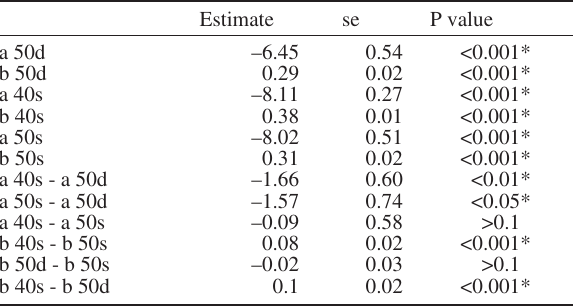
Table 3. – Logistic parameters (a and b) estimated by the mixed- effects model for the three mesh configurations (50d, 50-mm dia- mond; 40s, 40-mm square; 50s, 50-mm square), standard errors (se) and pairwise comparison between mesh configurations. The asterisk indicates significant P values, i.e. <0.05.